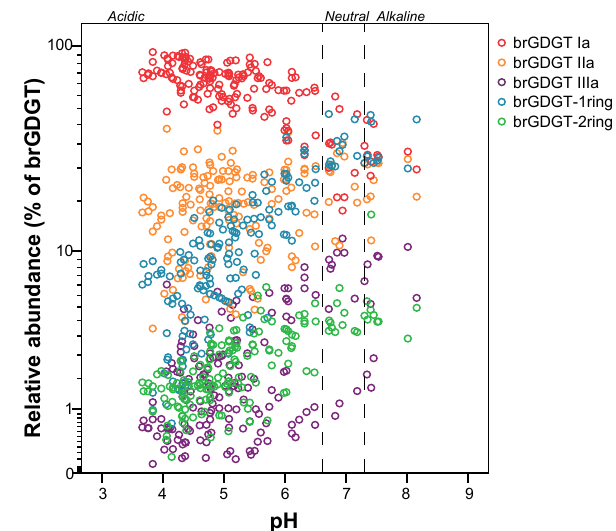
Figure 5. Relative abundance of brGDGT plotted vs. measured soil pH. Note logarithmic scale for relative abundance. Dashed lines in- dicate neutral soil conditions, which delimitate the interval between 6.6 and 7.3 pH